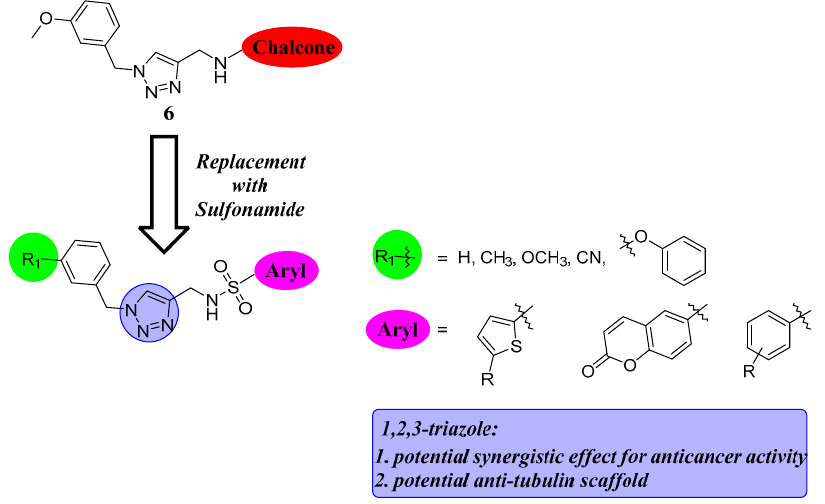
Figure 4. Rational design strategy for novel sulfonamide-1,2,3-triazoles.